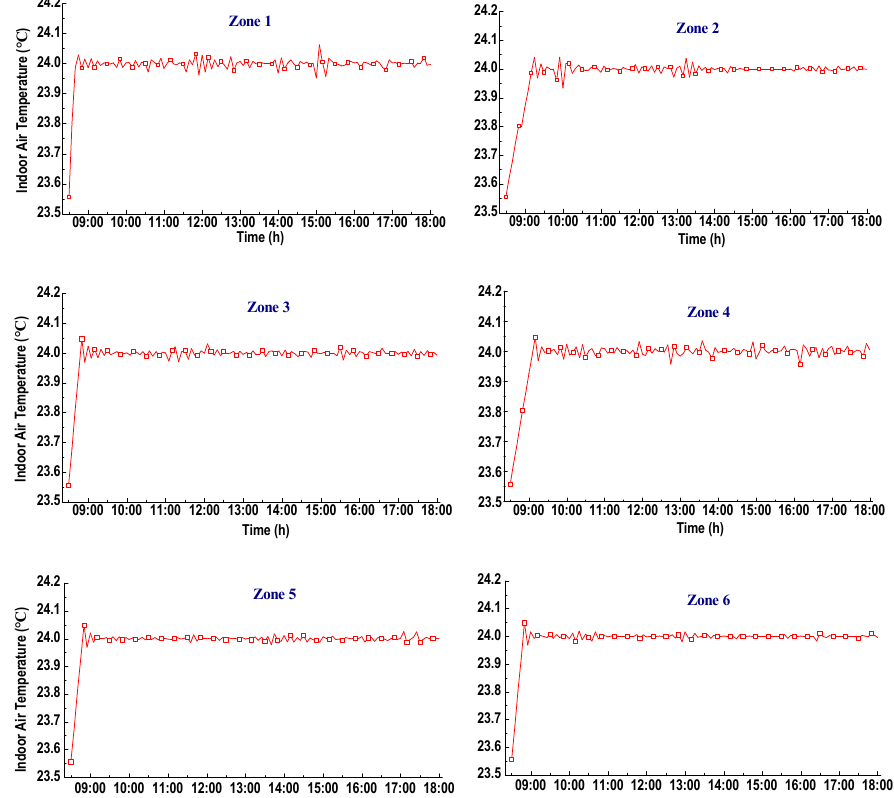
Figure 4. The indoor air temperature of six zones under Scenario 1.